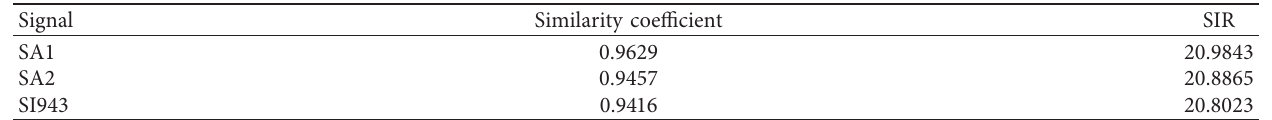
Figure 17: Spectrum diagram of speech signal extraction under quantum chaos: (a) SA1 speech signal; (b) SA2 speech signal; (c) SI943 speech signal. Table 1: Characteristics needed to detect